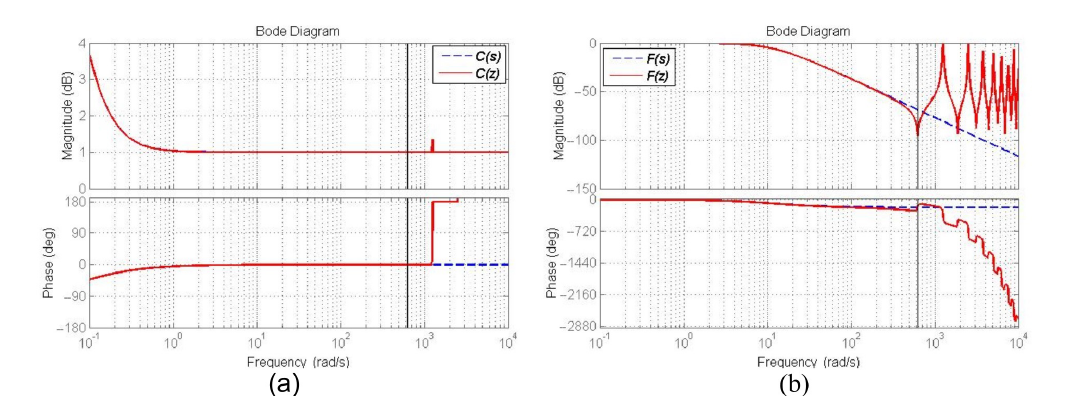
Figure 17. Bode diagrams of ( a ): C ( s ) and C ( z ) , ( b ): F ( s ) and F ( z ) . It is well known that saturation in conjunction with integral control actions affects the performance of any control system. Therefore, to reduce undesired effects of saturation in the control signal, an “anti-windup” scheme was implemented in addition to the PI controller and the NRDOB. In this case the maximum voltage and current provided by the power source are ± 50 V and ± 3 A, respectively. The real-time SIMULINK program of the NRDOB_PI control system, including “anti-windup”, for the series DC motor is presented in Figures 18 and 19.